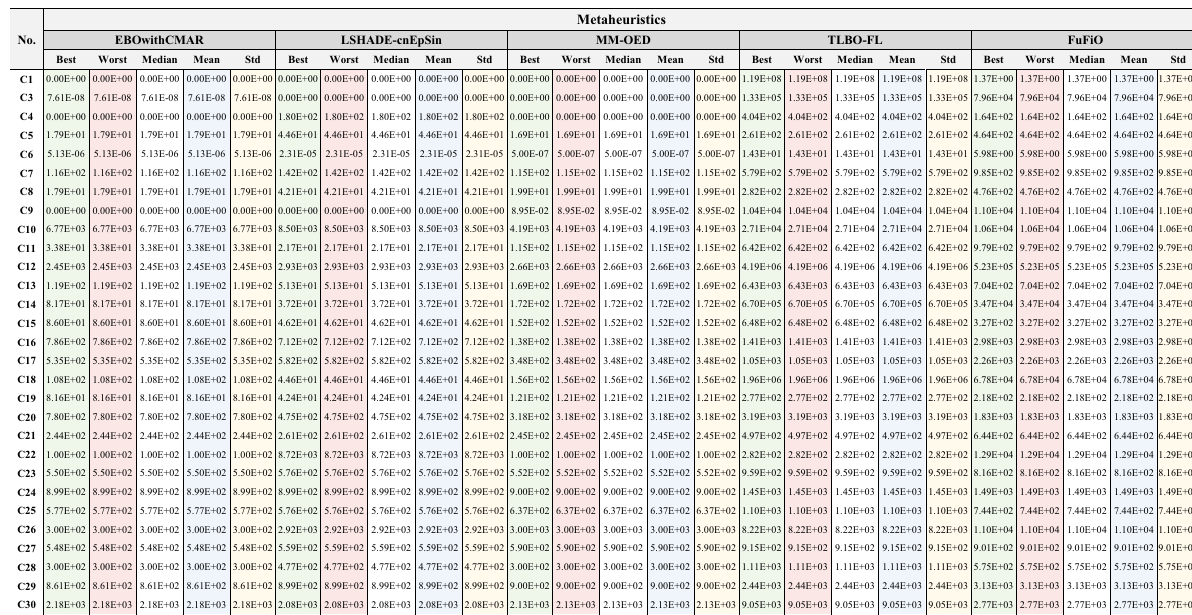
Table 16. Statistical results of different algorithms for the 100-dimensional CEC-2017 problems.